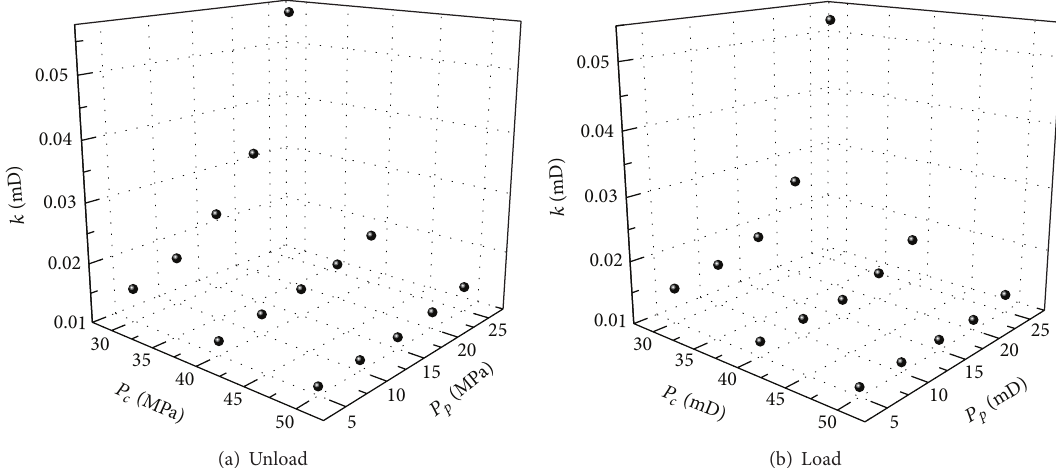
Figure 7: Permeability versus pore pressure and confining pressure measured by nitrogen when unloading (a)/loading (b) the pore pressure under three different confining pressure conditions.